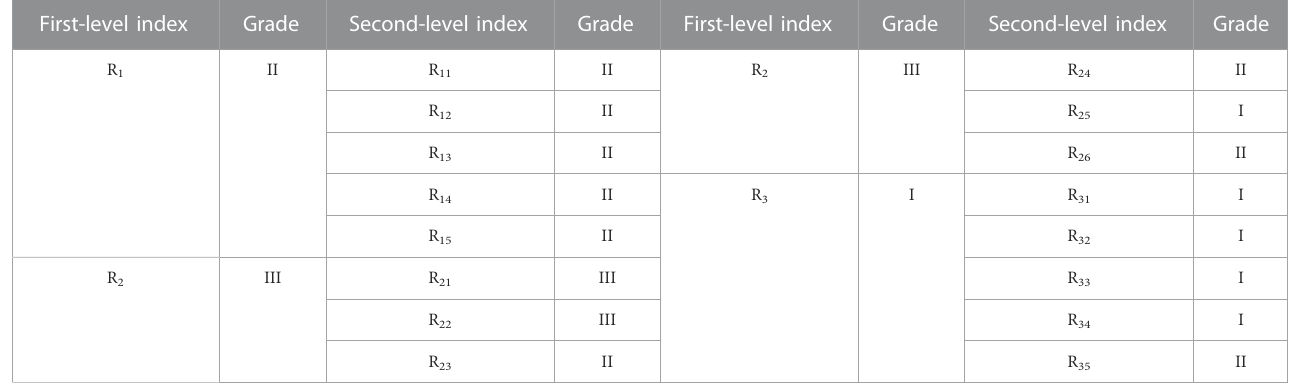
TABLE 4 Sustainability assessment grade of each